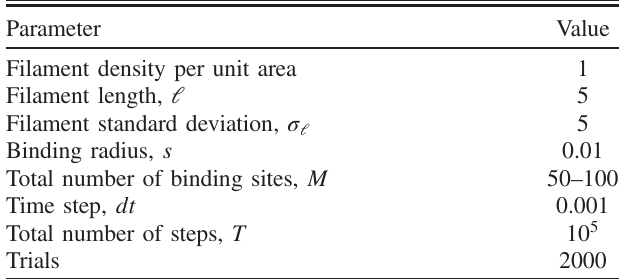
TABLE I. Simulation parameters.